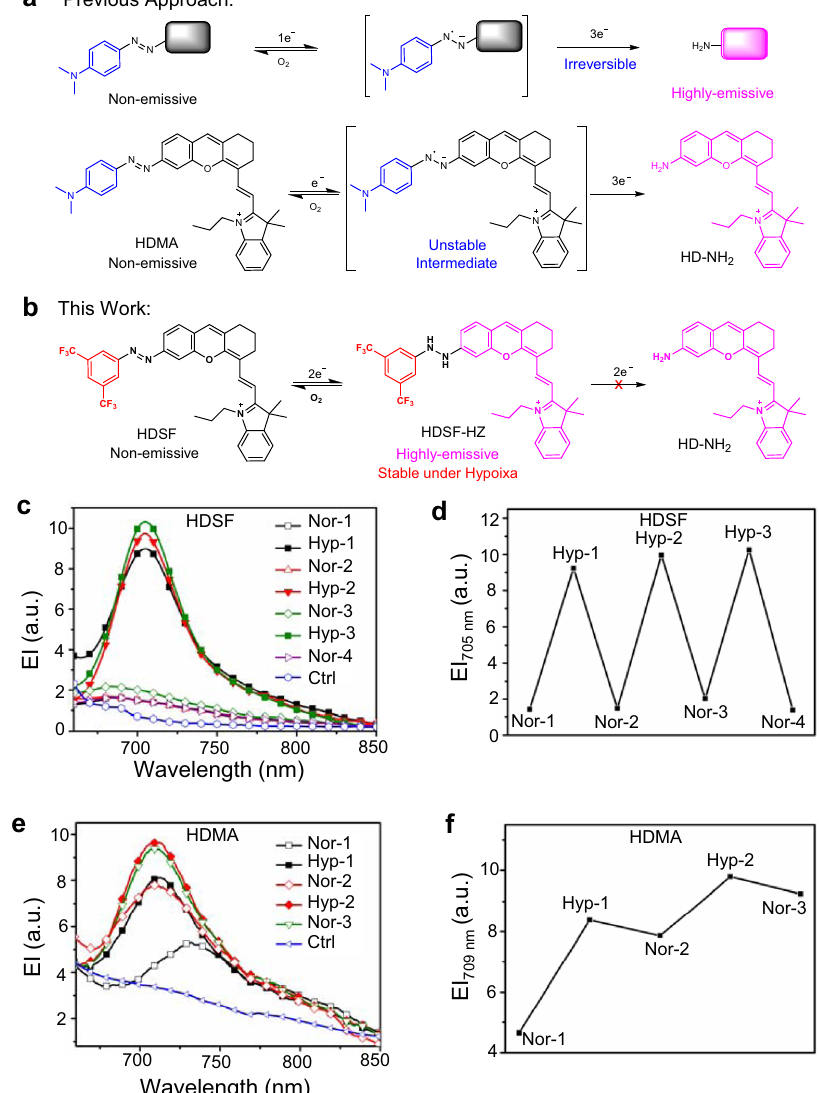
Fig. 1 Reversible imaging mechanism and behavior of HDSF. a Normal azobenzene-derived fl uorescent probes for hypoxia and their reductive decomposition of N – N bond by the hypoxic microenvironment in living systems. b The reversible hypoxia sensing mechanism of probe HDSF. The square and fl uorophore in black represent the quenched- fl uorophore, and those in bright magenta represent the emitting- fl uorophore. c Fluorescent spectra of 20 μ M HDSF in PBS buffer (0.1 M, pH 7.4, 2% DMSO, v/v) containing rat liver microsomes (RLM, 250 μ g mL − 1 ) and NADPH (100 μ M) recorded in normoxia- hypoxia cycles. d Fluorescence intensity of HDSF at 705 nm detected in ( c ). e Fluorescent spectra of 20 μ M HDMA in PBS buffer (0.1 M, pH 7.4, 2% DMSO, v/v) containing RLM (250 μ g mL − 1 ) and NADPH (100 μ M) recorded in normoxia-hypoxia cycles. f Fluorescence intensity of HDMA at 709 nm detected in ( e ). Ctrl: PBS buffer with RLM and NADPH. λ ex , 650